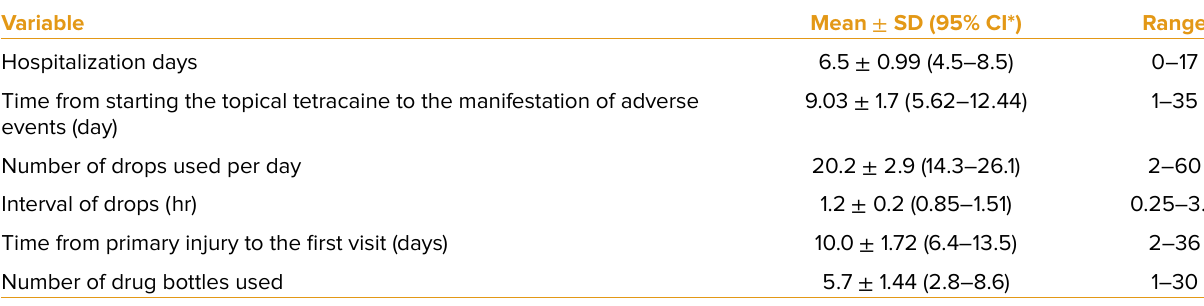
Table 2. Some characteristics of drug abuse and treatment of the patients who were referred to eye emergency department for adverse drug reactions of tetracaine in southeast of Iran ( n = 24